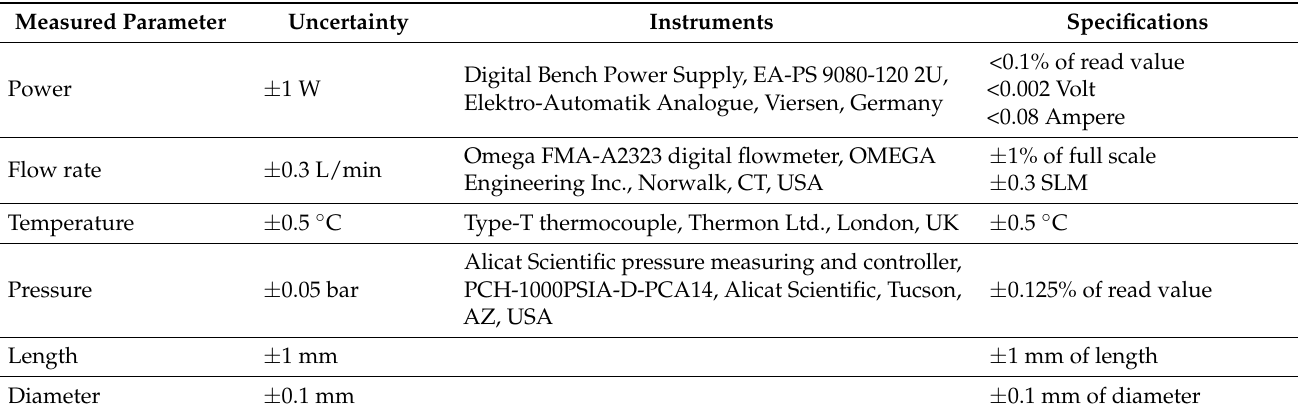
Table 1. The uncertainties and instruments of measured